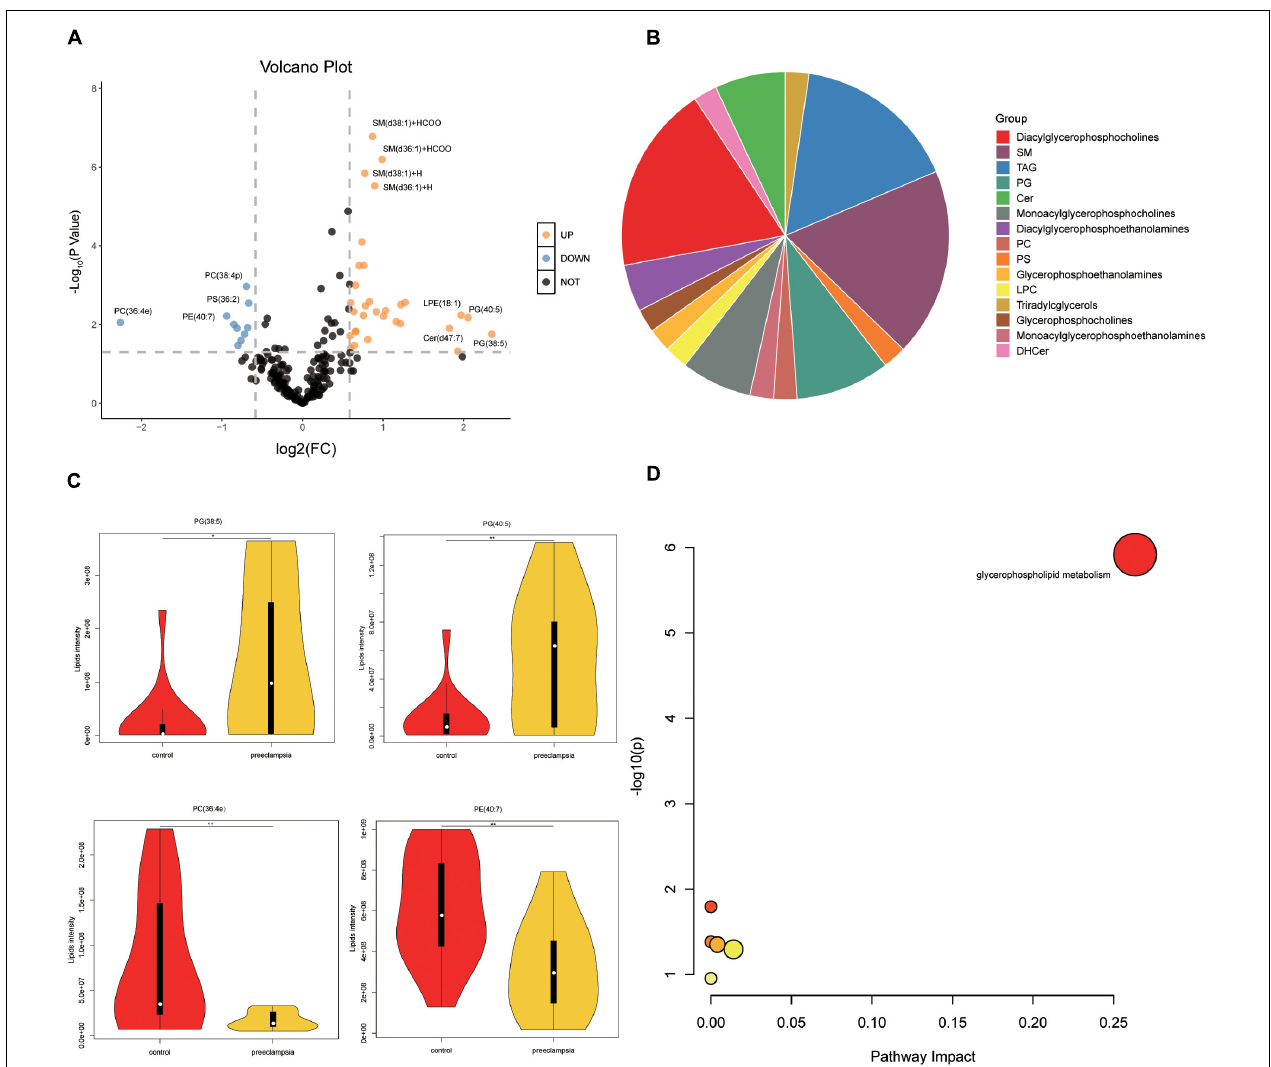
FIGURE 4 | Pathway analysis of lipids in placentas. (A) The volcano plot of lipids (VIP > 1). In the figure, the x-axis is the log2 for fold change (FC), and the y-axis is the -Log 10 for p -value. Lipids with FC > 1.5, p -value < 0.05 were shown in orange, and FC < 0.67, p -value < 0.05 are shown in blue. Others are shown in black. (B) The proportion of lipid subclasses of all differentially expressed lipids (VIP > 1 and p -value < 0.05). (C) The level of the top four upregulated or downregulated lipids in the control and preeclampsia group. (D) Pathway analysis lipids (VIP > 1, p -value < 0.05) using the KEGG database. The color gradient and circle size indicate the significance of the pathway ranked by p -values (yellow: higher p -values and red: lower p -values) and pathway impact scores (the larger the circle, the higher the impact score), respectively. Significantly affected pathways with a low p -value and high pathway impact score are identified by